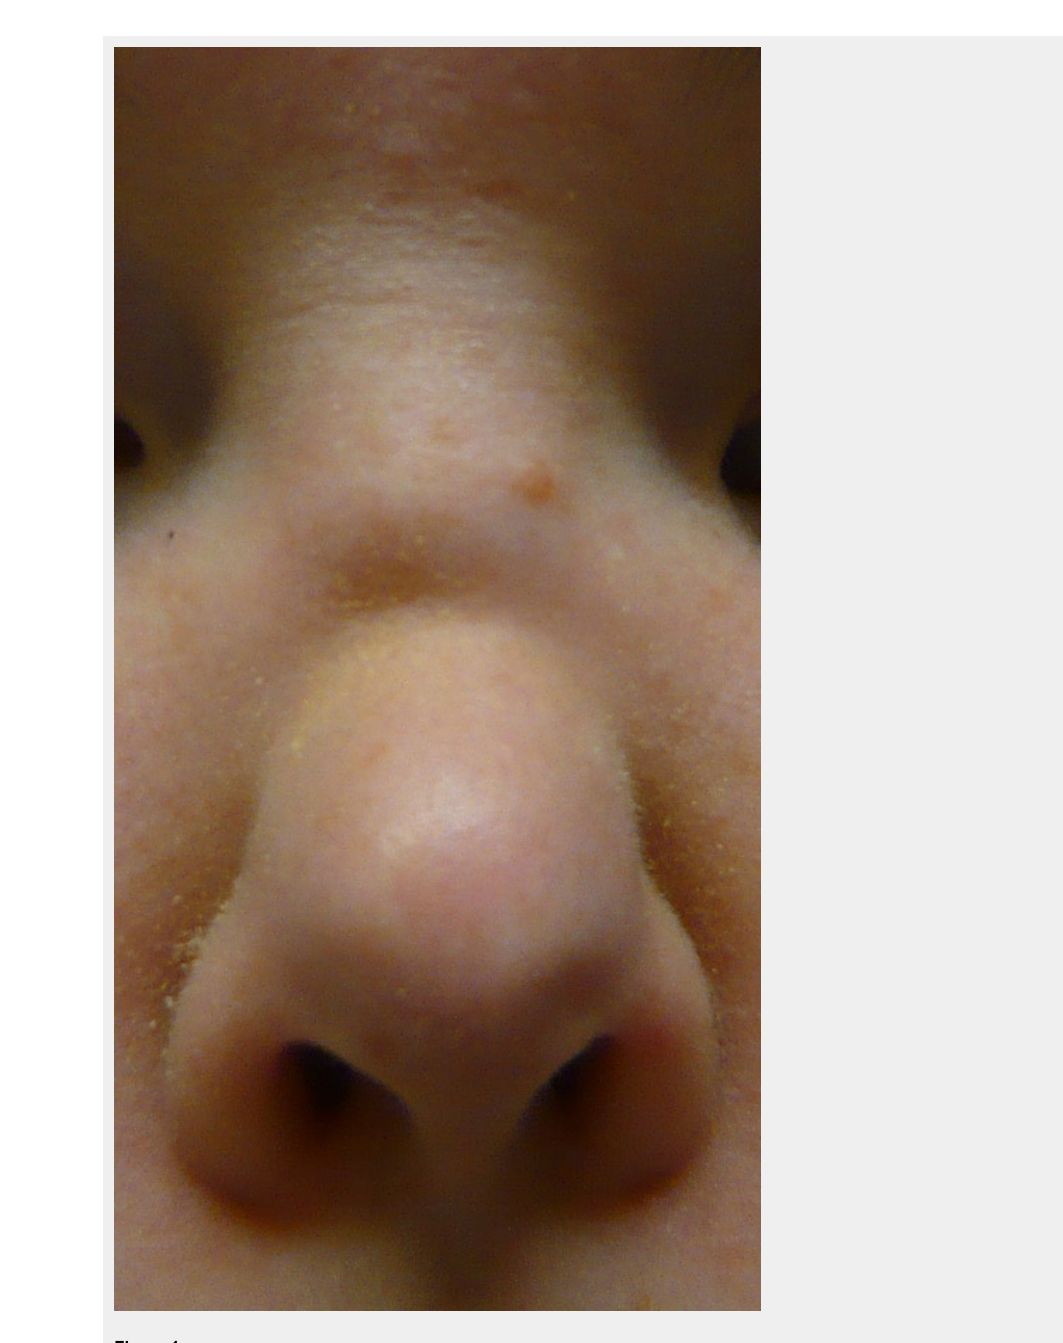
Nasal deformity in a patient with granulomatosis with polyangiitis (GPA). (Written informed consent for publication has been obtained from the